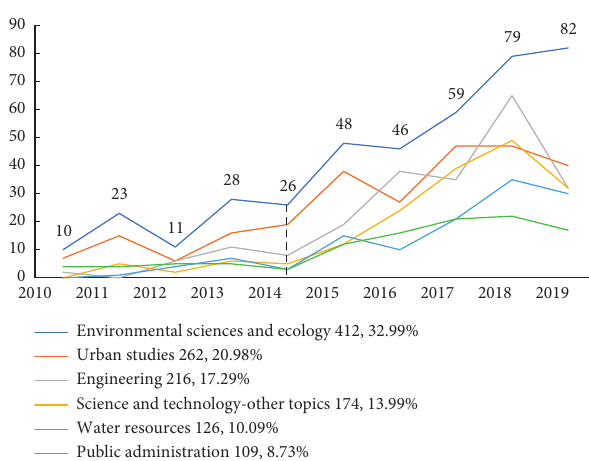
Figure 6: Trend of subject categories in the resilient city field with